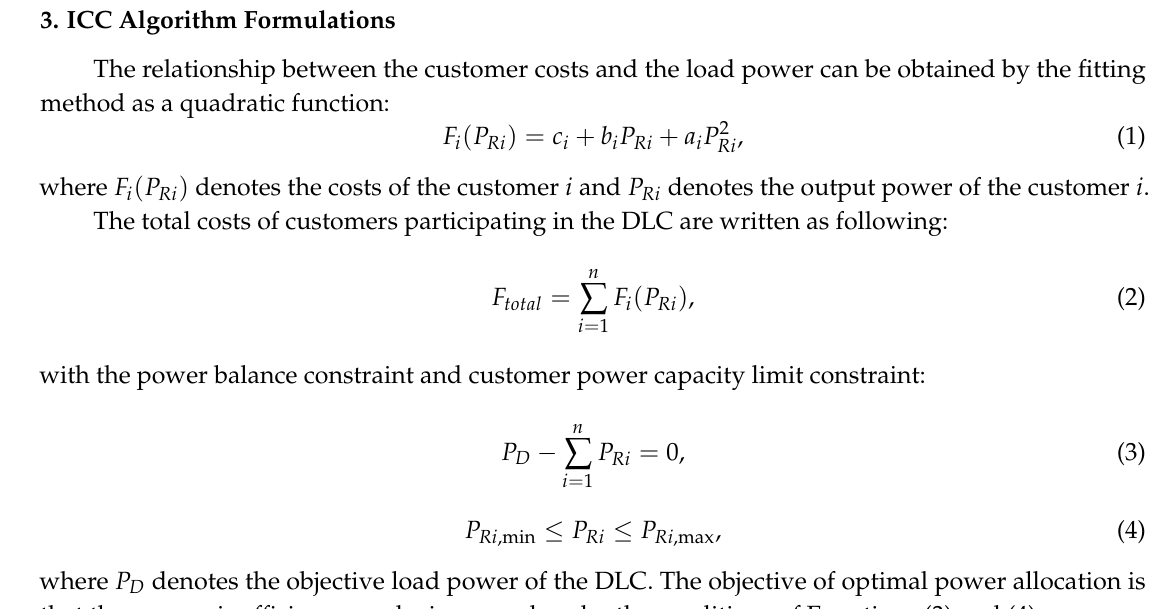
Figure 1. The overall flowchart of the proposed method.